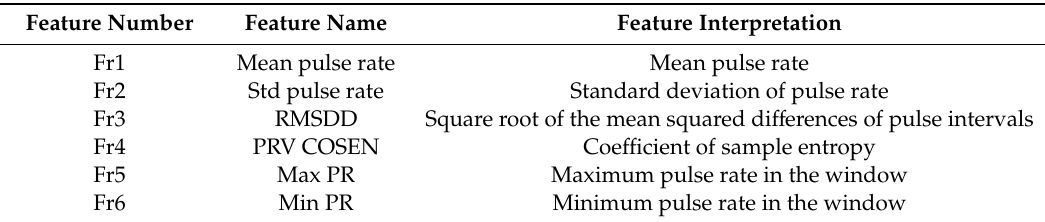
Figure A2. Diagrams of PPG-derived features. Table A1. Blood pressure (BP)- and PR-derived